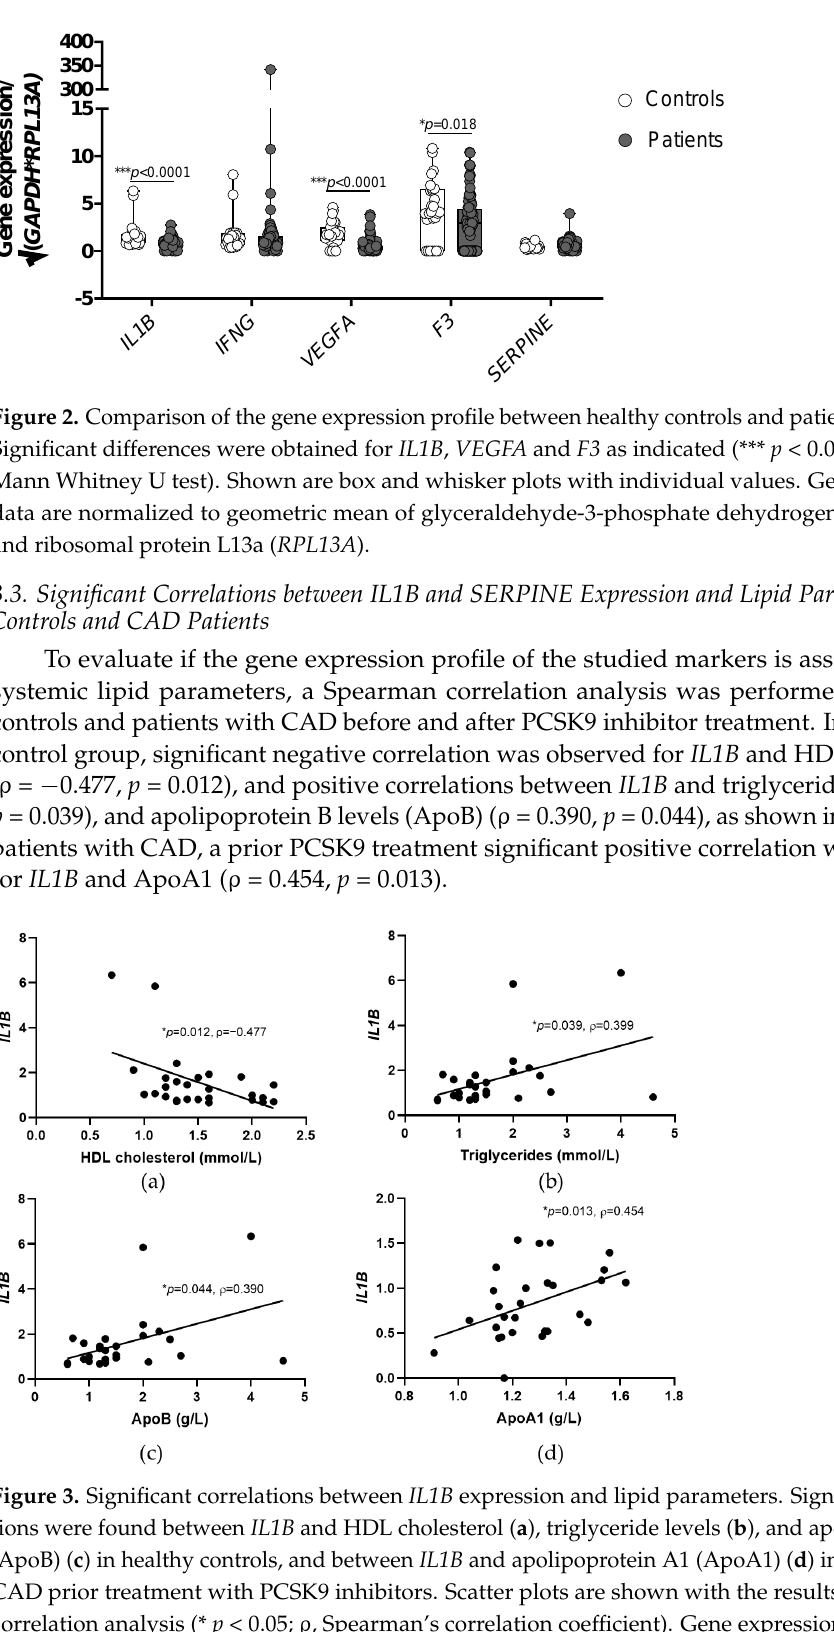
Figure 4. Significant correlations between SERPINE expression and lipid parameters in CAD pa- tients following PCSK9 inhibitors treatment. Significant correlations were found between SERPINE and LDL cholesterol ( a ) and apolipoprotein B (ApoB) ( b ) in patients with CAD after six months of PCSK9 inhibitors treatment. Scatter plots are shown with the results of Spearman correlation anal- ysis (* p < 0.05; ρ , Spearman ’ s correlation coefficient). Gene expression data are normalized to geo- metric mean of glyceraldehyde-3-phosphate dehydrogenase ( GAPDH ) and ribosomal protein L13a ( RPL13A ). 3.4. Treatment with PCSK9 Inhibitors Influences the Expression of VEGFA, F3 and SERPINE To evaluate the effect of the treatment with PSCK9 inhibitors on gene expression of the studied markers in patients with CAD, the data on gene expression at baseline and after six months of treatment were compared (Figure 5). Statistically significant